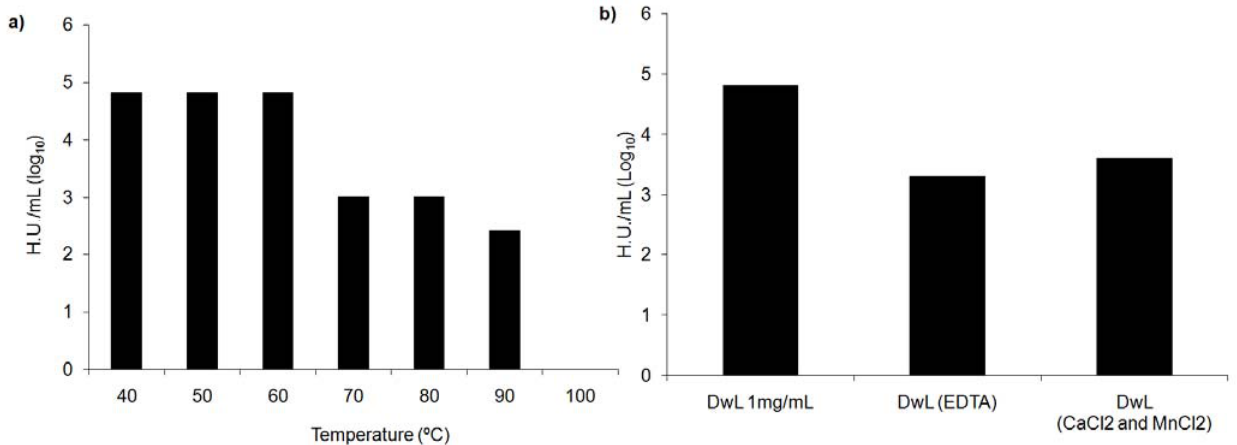
Figure 2. Stability of Dioclea wilsonii (DwL) hemagglutinating activity. ( a ) DwL thermostability. ( b ) DwL metal dependence. HA against trypsinized rabbit erythrocytes (0.2 M ultrapure EDTA followed by 0.15 M ultrapure NaCl) in presence or not of CaCl and MnCl 2